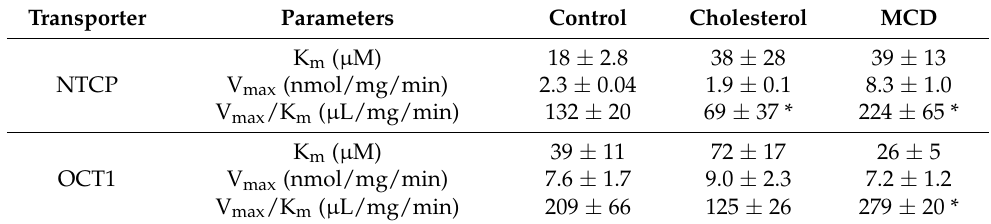
Figure 7. Normalized kinetics of NTCP-mediated taurocholate uptake after treatment with choles- terol or MCD. Uptake of increasing concentrations of taurocholate was measured at 37 °C for 15 s